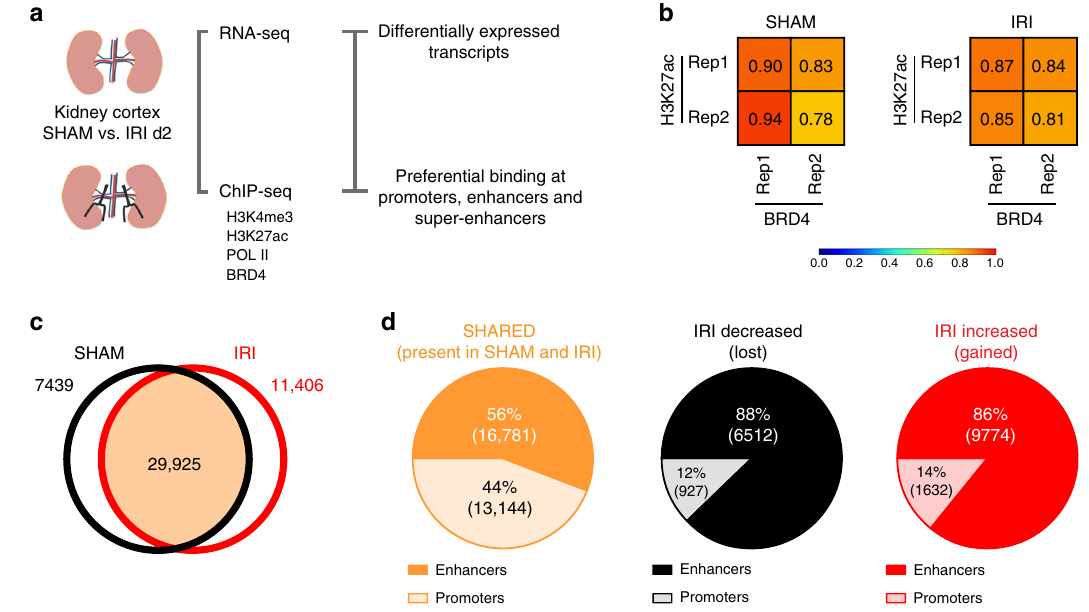
Fig. 1 Identi fi cation of enhancer elements. a Work fl ow of the experimental approach. b H3K27ac marks and BRD4 binding sites strongly correlate in both SHAM and IRI samples. c Broad peak calling was applied on H3K27ac SHAM and IRI samples. 29,925 peaks overlapped between them; 7439 and 11,406 were only identi fi ed in SHAM or IRI samples, respectively. d 56% of the identi fi ed peaks SHARED between both samples are enhancer elements, whereas 44% are promoter elements. Peaks identi fi ed with preferential binding in SHAM samples (IRI-decreased) consist of 88% enhancers and 12% promoter regions. Out of 11,406 peaks identi fi ed with preferential binding in IRI samples (IRI-increased) 86% are enhancers and 14% are